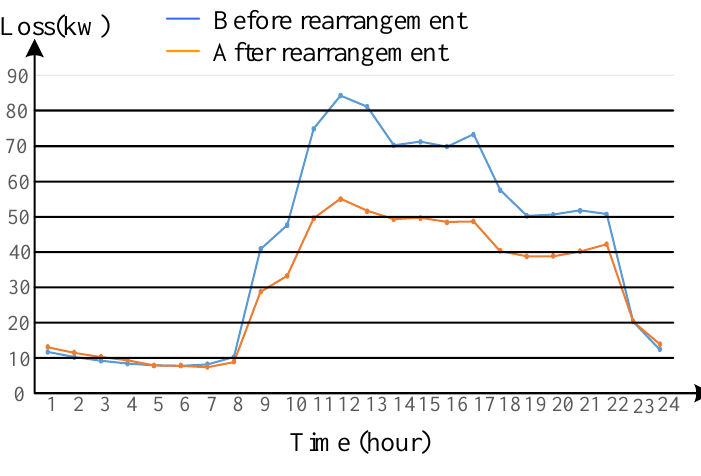
Figure 9. The total line loss profiles.